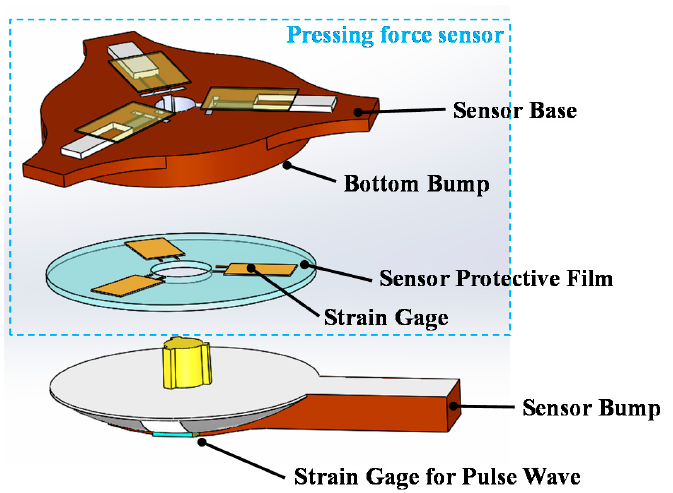
Figure 4. Schematic of the proposed strain-based pulse wave sensor.